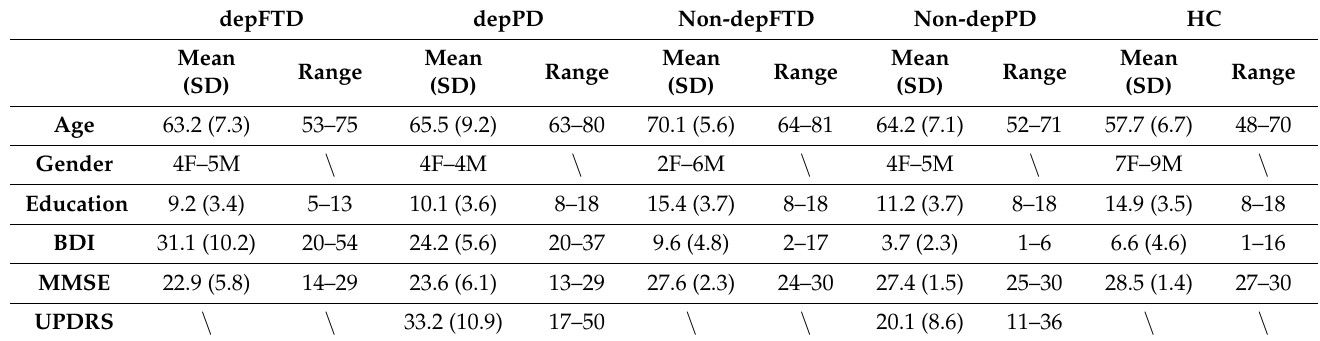
Table 1. Demographic and neuropsychological data in the five groups. (depFTD: depressed FTD patients; depPD: depressed PD patients; non-depFTD: non-depressed FTD patients; non-depPD: non-depressed PD patients; HC: healthy controls. Age and education expressed in